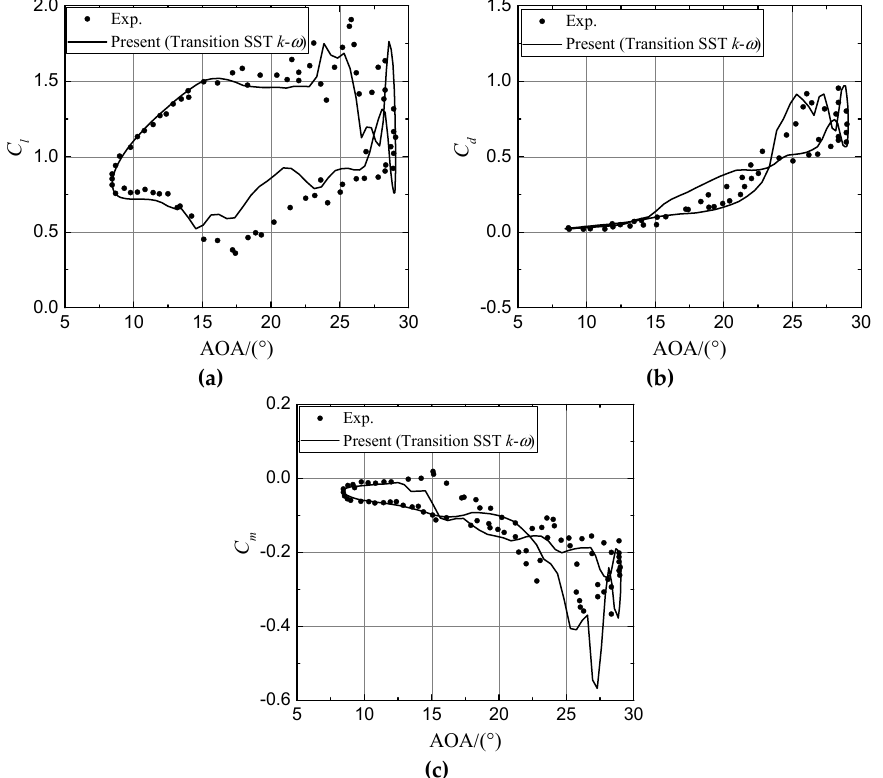
Figure 6. Aerodynamic coefficients in deep stall of the NREL S809 airfoil under pitch oscillation. α mean = 20 ° , A = 10 ° , k = 0.078, and Re = 1 × 10 6 . ( a ) C l ; ( b ) C d ; ( c ) C m .